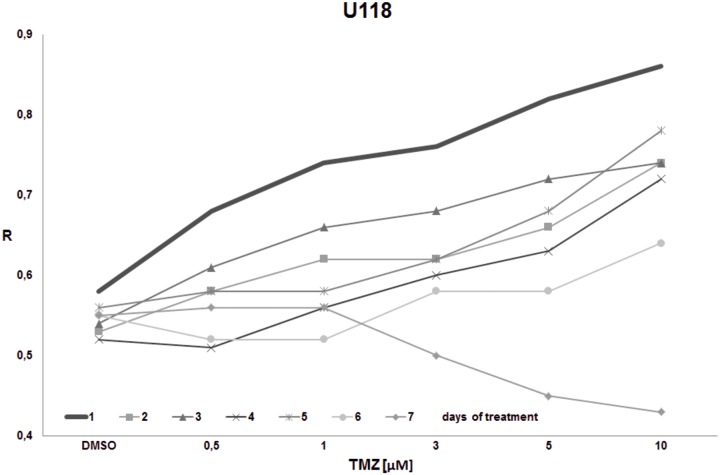
The impact of TMZ exposure period on DNA methylation in U118 cell line.U118 cell culture was treated with the given single dose of TMZ (0.5, 1, 3, 5, 10 μM) and left for 1–7 days. The global DNA methylation was estimated after 1st, 2nd, 3rd, 4th, 5th, and 7th day of incubation. A general hypermethylation is observed, with no initial hypomethylating effect in lower concentration range. Hypomethylation after 7 days starts with concentrations over 1 μM.